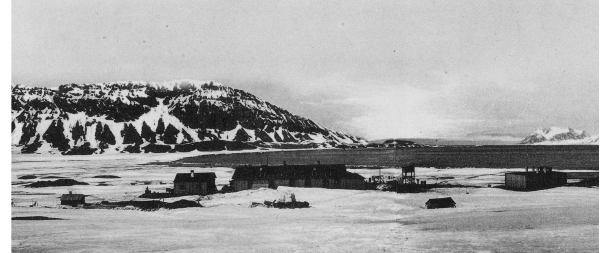
Fig. 2. Photo of the Russian-Swedish expedition base with equip- ment for auroral observations in the Konstantinovka settlement at Figure 2. Photo of the Russian-Swedish expedition base with equipment for auroral Hornsund. observations in the Konstantinovka settlement at Hornsund.